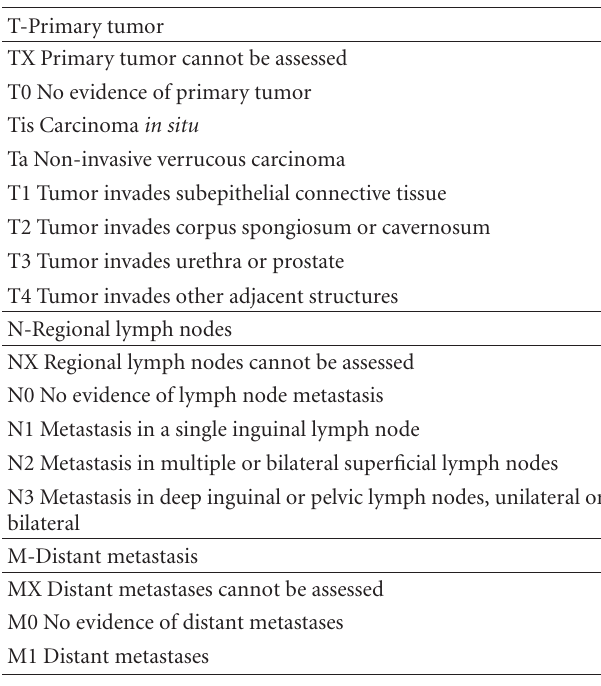
Table 1: TNM classification of penile carcinoma